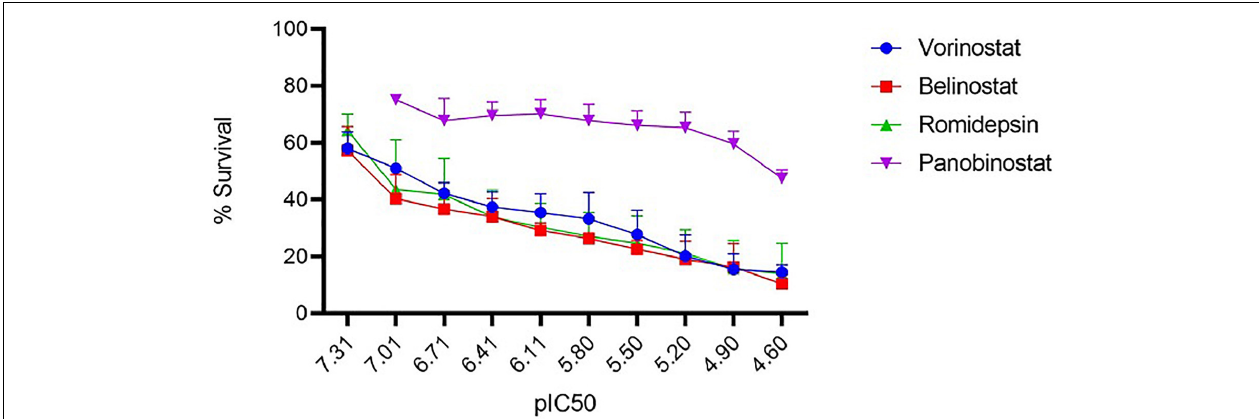
FIGURE 1 | In vitro antitheilerial activity of histone deacetylase (HDAC) inhibitors. Dose-response curves against the four HDACi in T. annulata infected cells. IC 50 was calculated using a resazurin dye-based assay. The IC 50 values of vorinostat, belinostat, romidepsin, and panobinostat was 0.103 ( ± 0.005) µ M, 0.069 ( ± 0.004) µ M, 0.20 ( ± 0.006) µ M, and 20.80 ( ± 3.11) µ M, respectively. IC 50 values are represented as the negative log of IC 50 in Molar referred to as pIC 50 (ranged from 7.31 to 4.60 referring to IC 50 concentration from 0.097 to 25 µ M). The graph represents the mean % survival at different concentrations of HDACi. ± represents the standard deviation (SD) from the three independent experiments. All the experiments were done in triplicates.